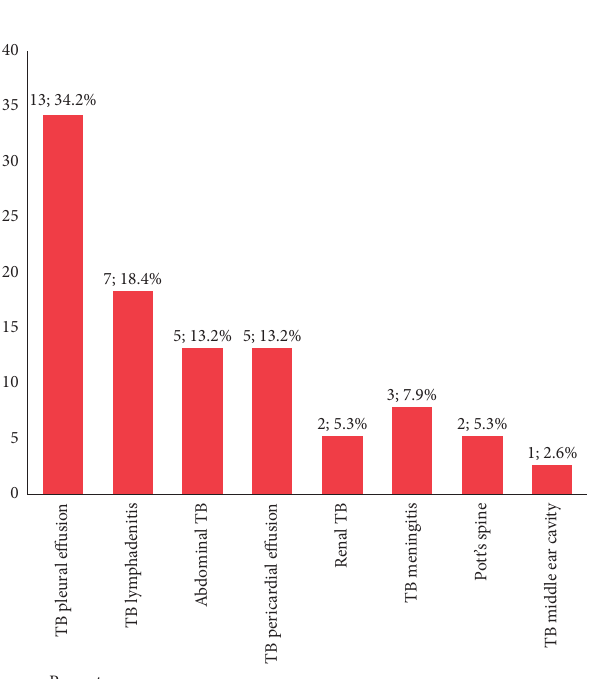
Figure 3: Types of extrapulmonary TB in patients with CKD ( n �